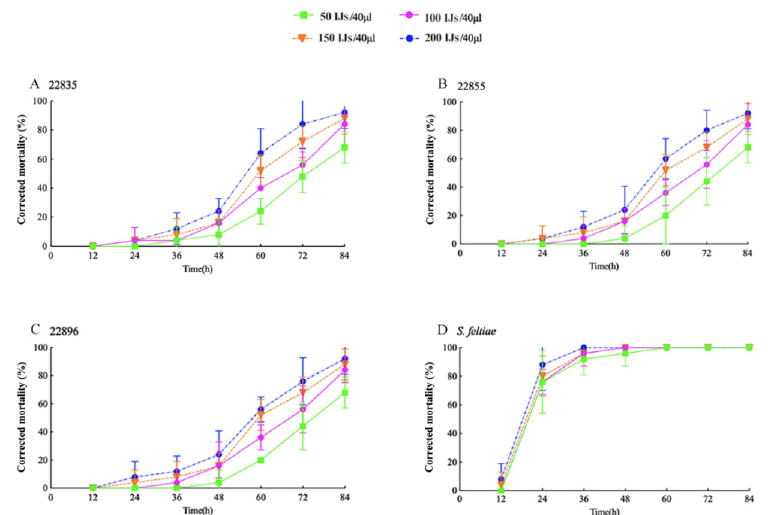
Figure 4. Corrected mortality of the third-instar larvae Spodoptera frugiperda treated with different concentrations of entomopathogenic nematodes for 12, 24, 36, 48, 60, 72, and 84 h. Mortality was corrected with control. Significant differences among different treatments by Tukey’s test ( p < 0.05) are shown in Table S1. Error bars represent standard error. ( A ) 22835: Oscheius myriophilus ; ( B ) 22855: Heterorhabditis spp.; ( C ) 22896: Oscheius spp.; ( D ) S. feltiae : Steinernema feltiae